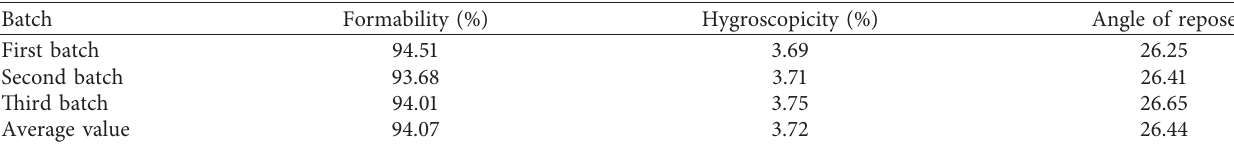
Figure 2: Response surface 3D map of each dependent variable relative to its respective variable. Table 5: Results of verification ( n �